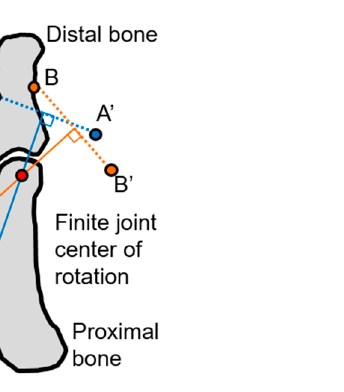
Figure 9. Determination of finite finger joint center of rotation (CoR) between two postures by Reuleaux’s method.